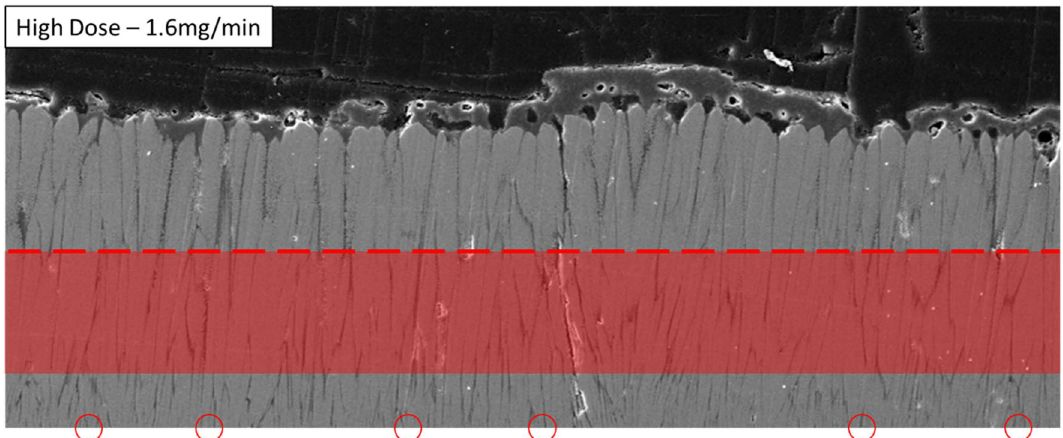
indicates initial theoretical freeze line. Translucent band indicates potential movement of freeze line with CMAS infiltration